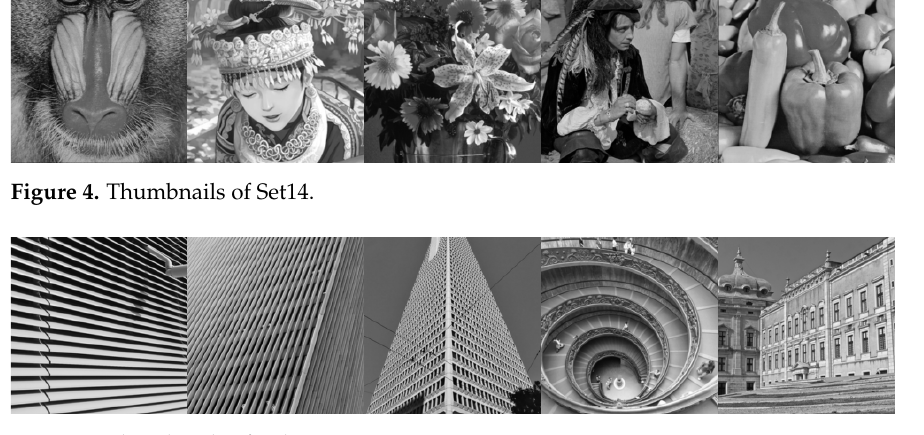
Figure 5. Thumbnails of Urban100.